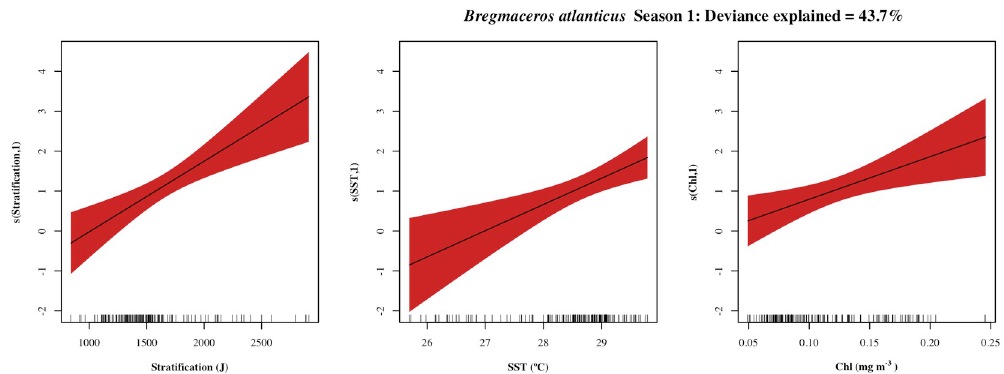
Fig 5. Response plots of the oceanographic variables’ additive effect on the density of Bregmaceros atlanticus . Season I (April-July) in red and season II (August-October) in blue. Smoothed values represented by a continuous line, and shaded color indicates 95% confidence intervals. variables with non-significant additive effects (p > 0.05) for a given season are not presented.